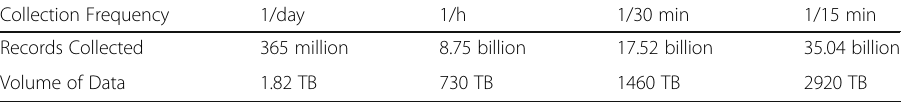
Table 1 Quantification of collected data in different sampling rates (Big Data analytics and energy consumption,